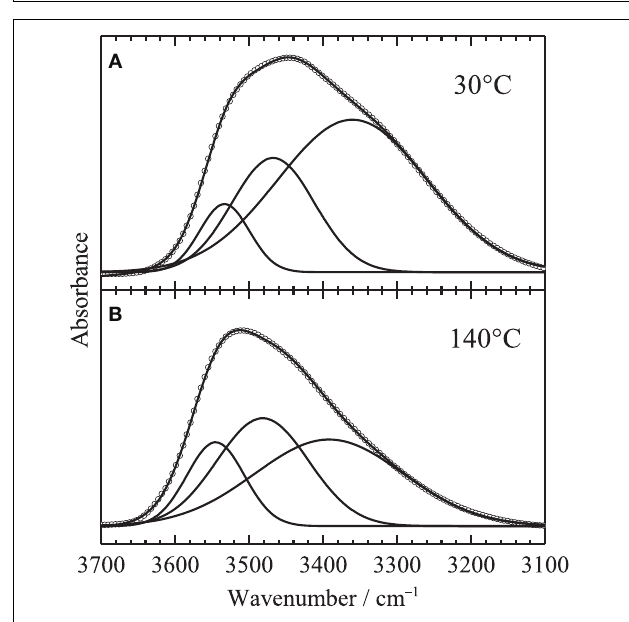
FIGURE 3 | Typical results of the curve fitting in the O-H stretching region assuming three Gaussian components at (A) 30 ◦ C and (B) 140 ◦ C. Circles and lines in the figure correspond to observed data and fitted lies with the three